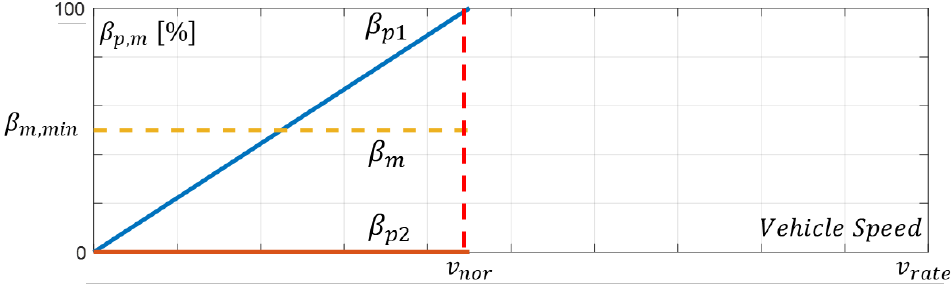
Figure 9. Pump and Motor Control near the Most Frequent Operating Condition.